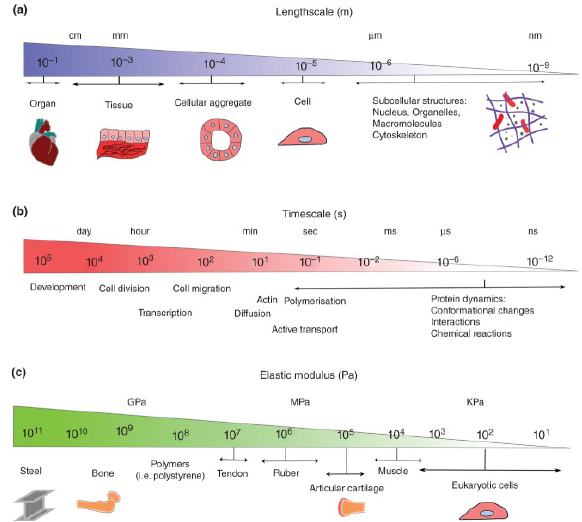
Figure 1. Multiple scales of soft biomaterials. ( a ) Length scales from the molecular to the organ level; ( b ) timescales of different physiological processes; and ( c ) comparisons of the elastic modulus among different typical materials. Reproduced with permission from